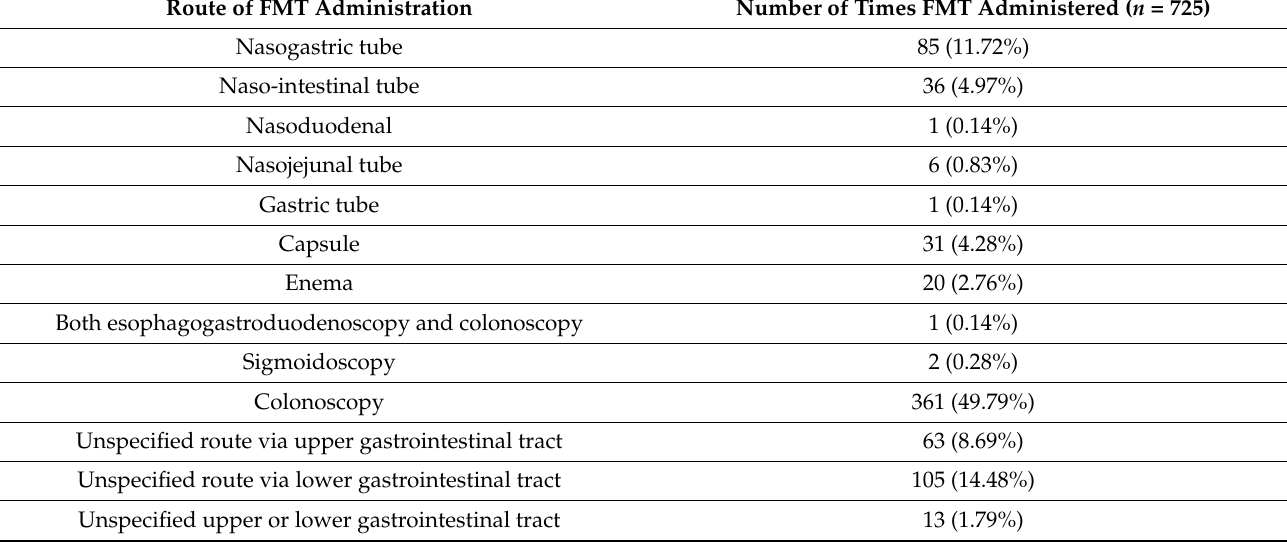
Table 2. Routes of FMT